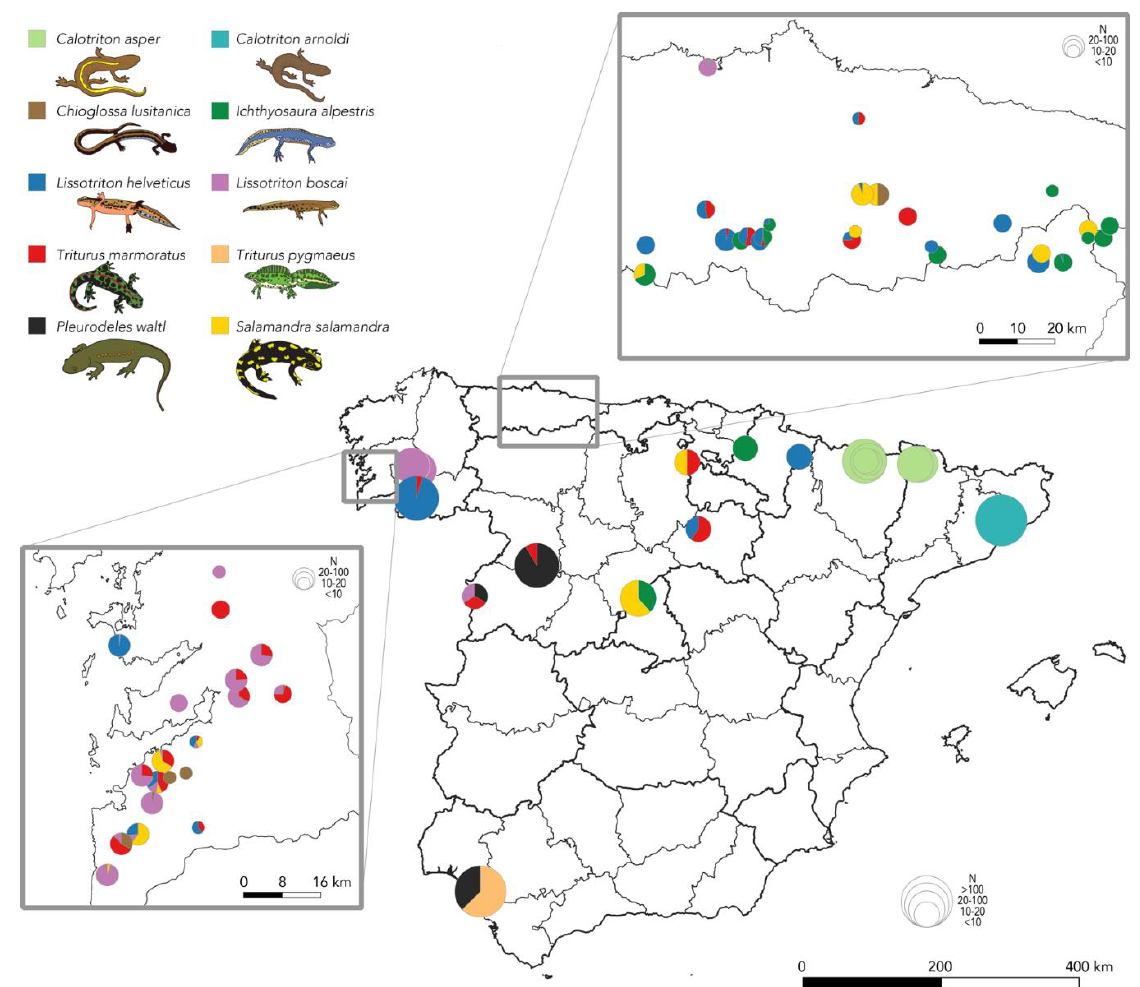
Figure 1. Map of Spain showing the location of urodele populations sampled between 2015 and 2021 for the presence of Bsal infection. None of the 1395 samples collected were positive. An intensive sampling effort was conducted in northern Spain due to recent reports of Bsal positive qPCRs from that area. Pie charts represent the proportion of sampled individuals of each species per location, and the sample size at each locality is indicated by the size of the pie chart.